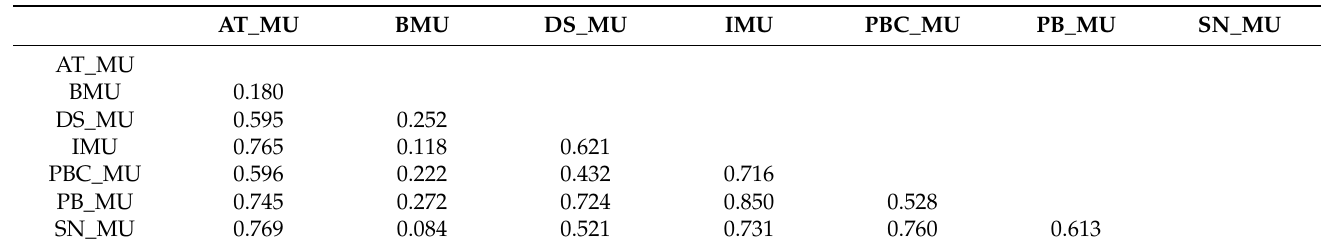
Table 4. Fornell–Larcker criterion.